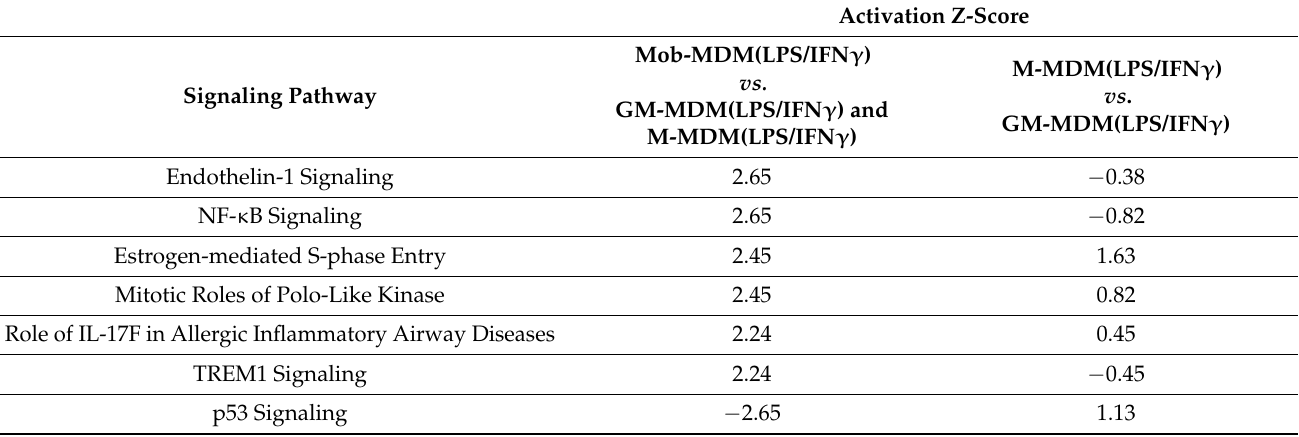
Table 2. Signaling pathways that are uniquely modulated in lipopolysaccharide (LPS)/interferon γ (IFN γ )-activated human monocyte-derived macrophages (MDMs) that were differentiated with HK M. obuense (Mob-MDM(LPS/IFN γ )) relative to those differentiated with macrophage colony-stimulating factor (M-MDM(LPS/IFN γ )) and granulocyte/macrophage colony-stimulating factor (GM-MDM(LPS/IFN γ